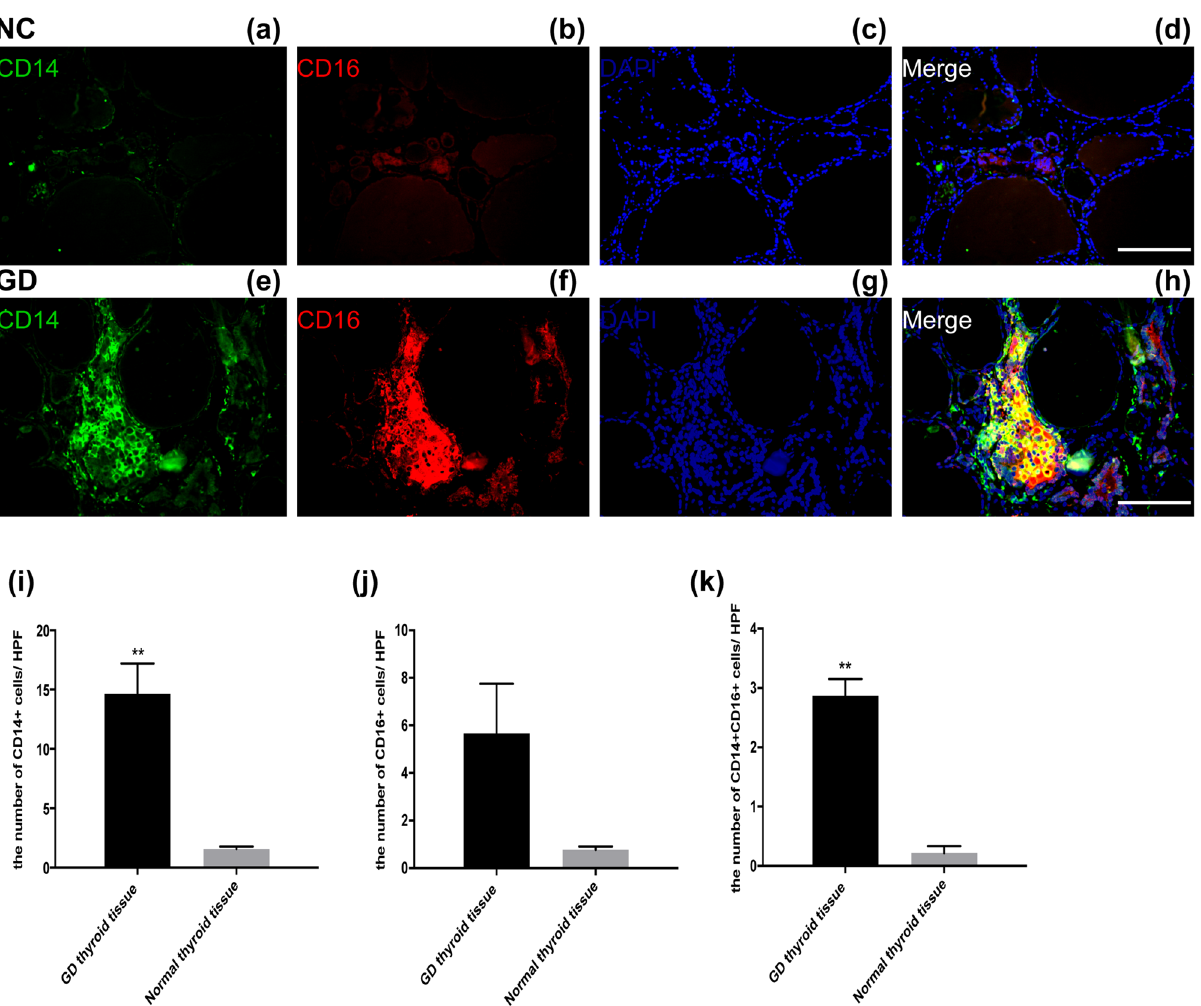
Figure 3. CD14 and CD16 expressing monocytes in the thyroid tissues of patients with Graves’ disease. Immunofluorescence staining was carried out using the samples of the normal thyroid tissues of patients with thyroid nodules (a–d) and patients with Graves’ disease (e–h) . The scale was 100 μm. Cells that co-express CD14 (green) and CD16 (red) markers in a similar location were yellow in color. The frequency of CD14+ , CD16+ and CD14+ CD16+ cells were calculated per high power field (HPF, × 400) in multiple samples: NC (n = 3, 15 sections) and GD (n = 6, 30 sections) were shown in (i–k) , respectively; ** P <